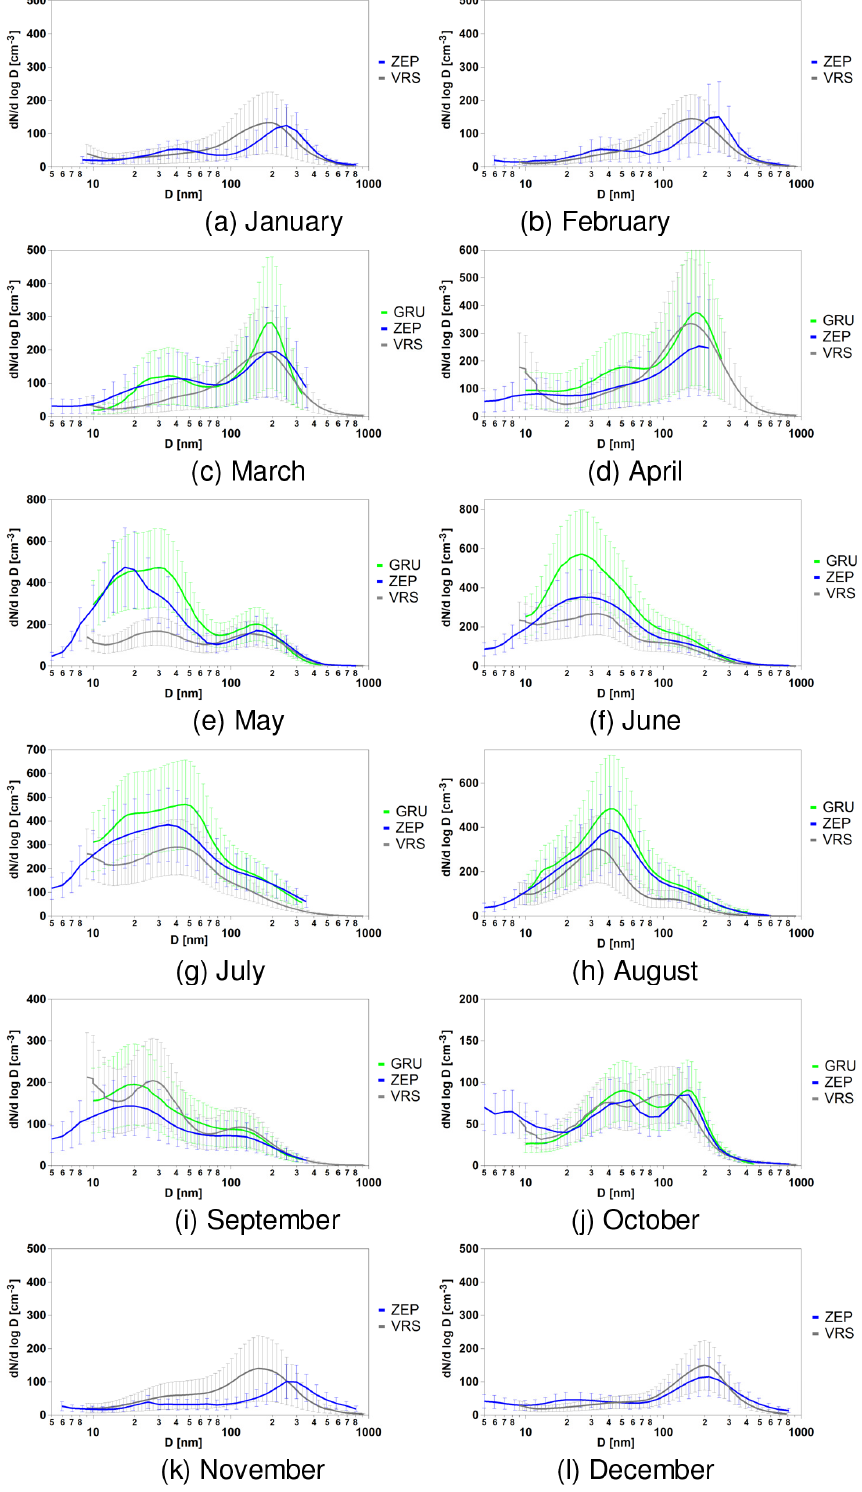
Figure 2. Monthly average size distributions taken at the three sampling sites for the period January–December (a–l) .